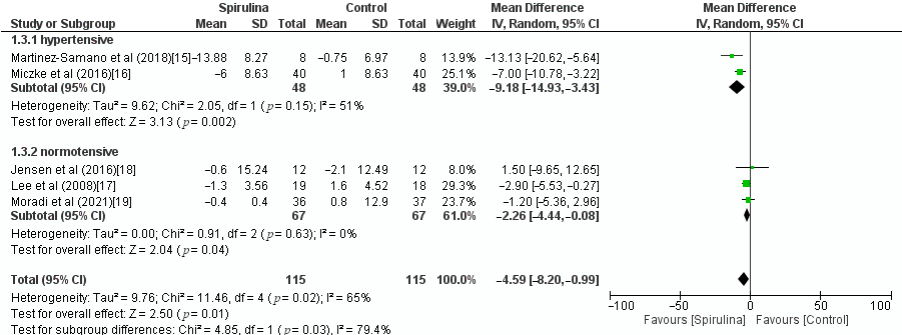
Figure 6. Effect of Spirulina supplementation on systolic blood pressure (SBP) compared with the